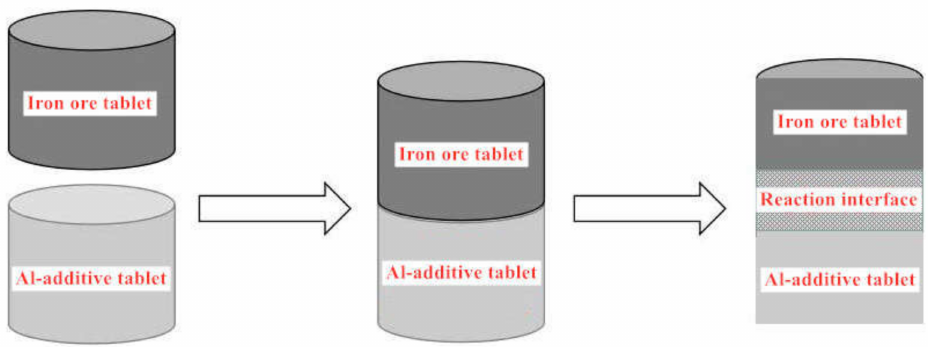
Figure 3. Schematic diagram of interface reaction